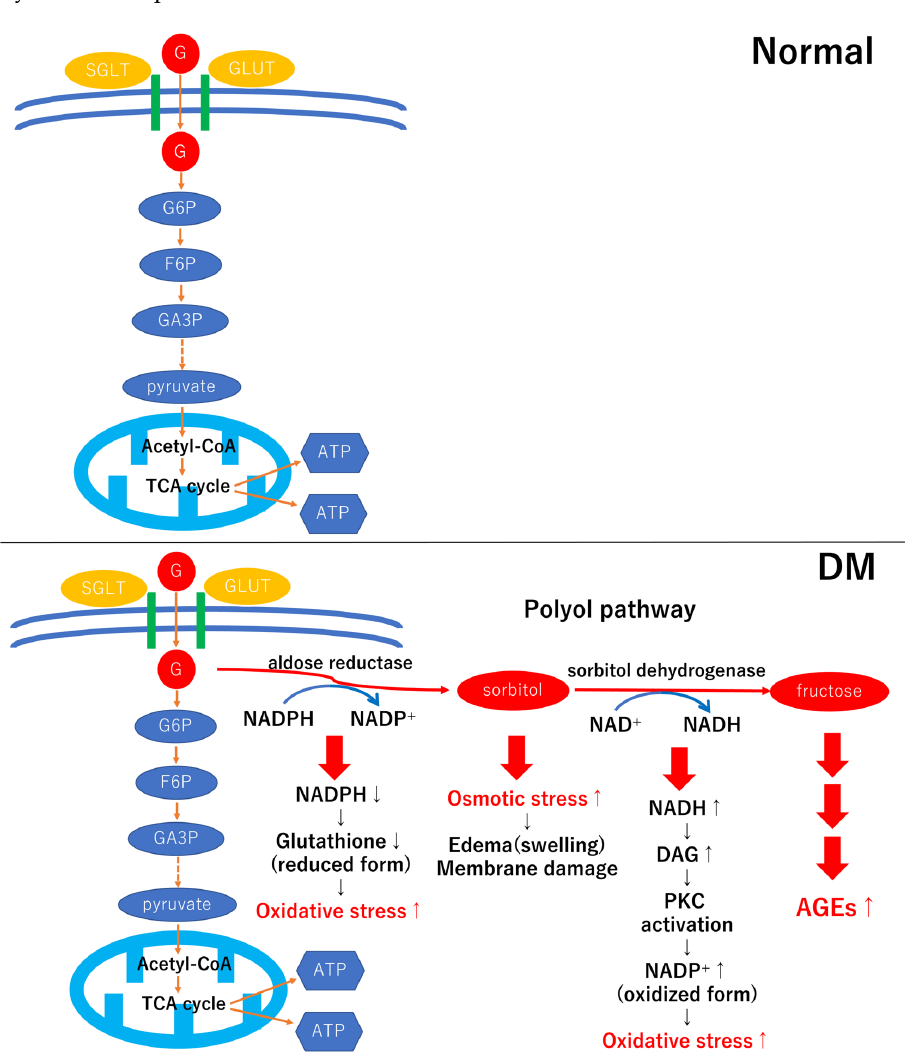
Figure 3. Scheme of the polyol pathway. Under normal conditions (upper figure), glucose is taken in by the retinal cells via sodium-glucose cotransporter (SGLT) or glucose transporter (GLUT). Glucose is converted to pyruvate by the metabolic glycolysis pathway. This process releases free energy to synthesize the high-energy molecule adenosine triphosphate (ATP) in the final step. In the diabetic condition, excessive uptake of glucose activates a minor cellular pathway, the polyol pathway (lower figure). The activated polyol pathway causes an increase in oxidative stress, osmotic stress, and AGE formation in diabetic retinas. G: glucose, G6P: glucose-6-phosphate, F6P: fructose-6-phosphate, GA3P: glyceraldehyde-3-P, NADP: nicotinamide adenine dinucleotide phosphate (NADP+; oxidized form, NADPH; reduced form), DAG: diacylglycerol, PKC: protein kinase C, AGEs: advanced glycation end products.